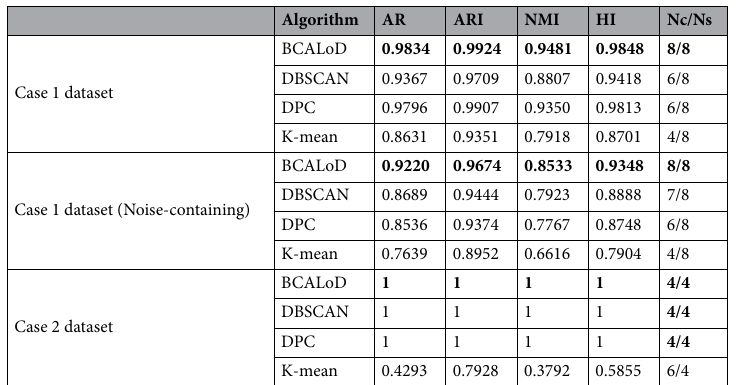
Table 2. Performance of BCALoD, DBcsan, DPC and K-mean. The bolded values are the best clustering quality indexes.